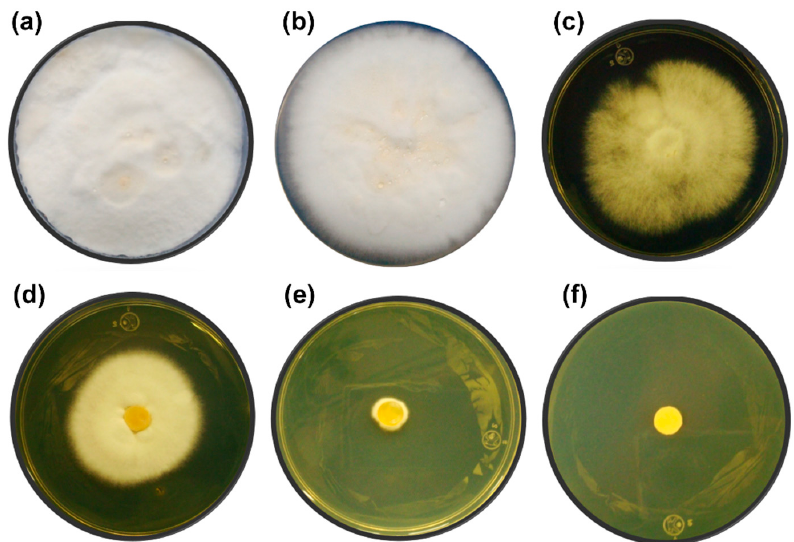
Figure 2. Ethanol tolerance test in solid yeast extract–malt extract agar medium (YMA) medium during10 days of incubation at 32 °C. ( a ) Control without ethanol, ( b ) 10% ( v / v ) ethanol, ( c ) 11% ( v / v ) ethanol, ( d ) 12% ( v / v ) ethanol, ( e ) 13% ( v / v ) ethanol, and ( f ) 14% ( v / v ) ethanol. The experiments were performed in triplicate.